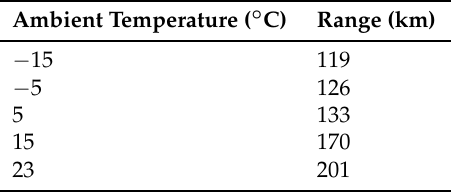
Table 6. Here, the efficiency, range, and comfort are demonstrated with the heat pump switched off and the PTC capacity increased to 6.5 kW, accounting for the reduction in compressor power